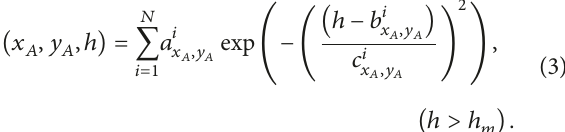
for arbitrary two adjacent measure points in the ML, where , 𝑦 𝑥 𝐴 𝐴 are the longitude and latitude of Argo profile and the depth of measurements; the fitting function 𝑇(𝑥 𝐴 , 𝑦 𝐴 , ℎ) between the two points